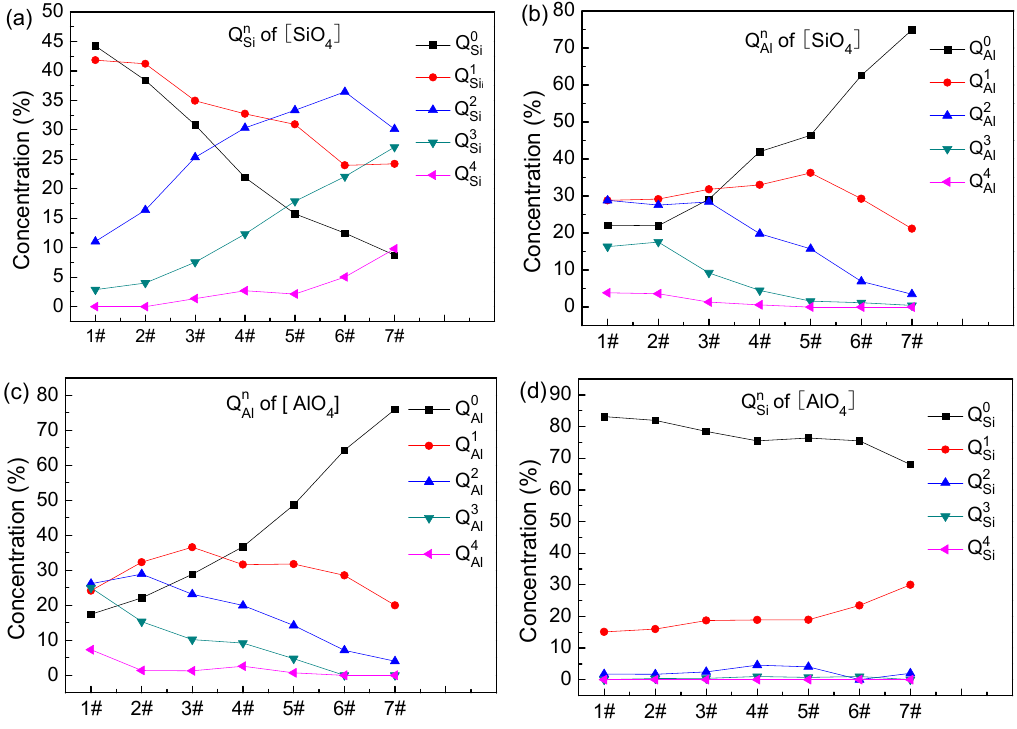
Figure 6. Distribution of Q n species: ( a , c ) [SiO 4 ] tetrahedron, ( b , d ) [AlO 4 ] tetrahedron.